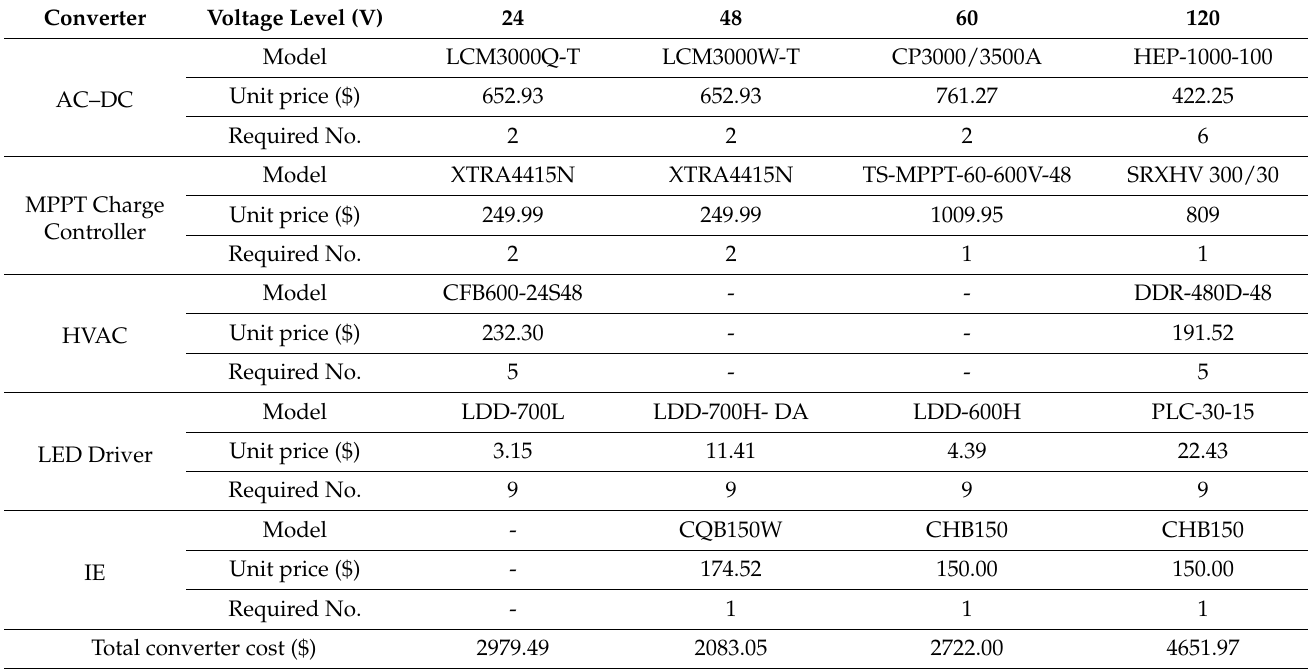
Table 2. Converters, their prices, and total converter cost at each voltage level.